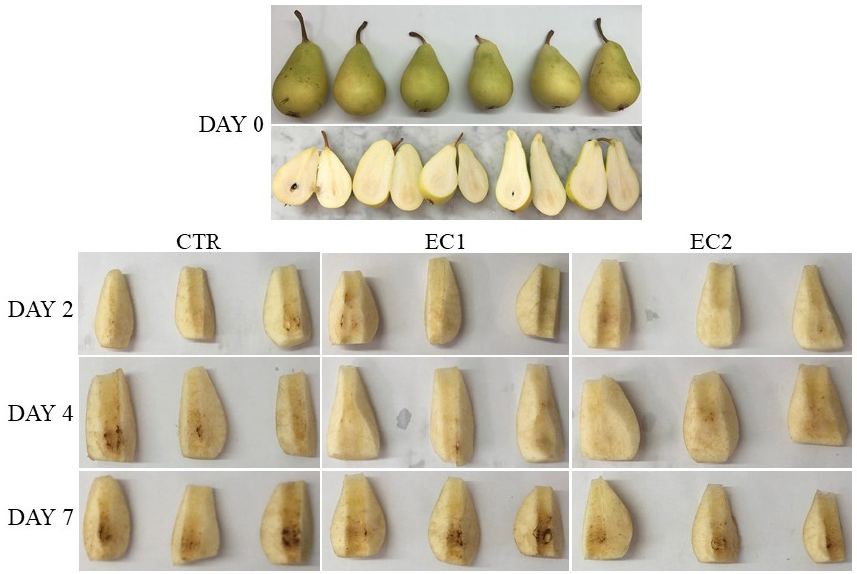
Figure 6. Visual aspect of untreated (CTR) and treated (EC1 and EC2) pear slices.